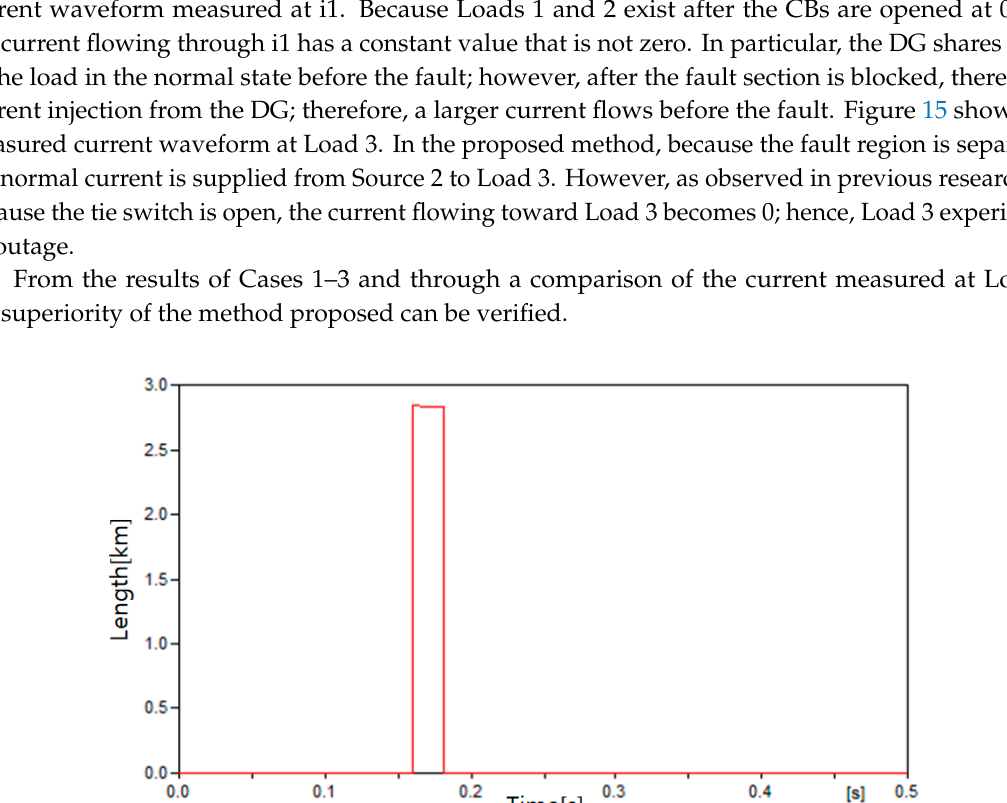
Figure 11. Current measured at I 1 in Case 2. Figure 12. Current measured at Load 3 in Case 2.